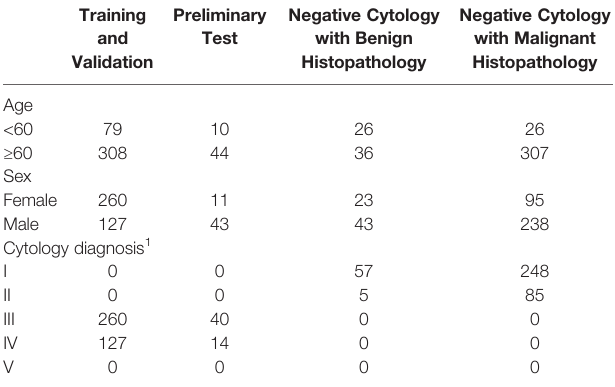
TABLE 1 | Baseline characteristics.